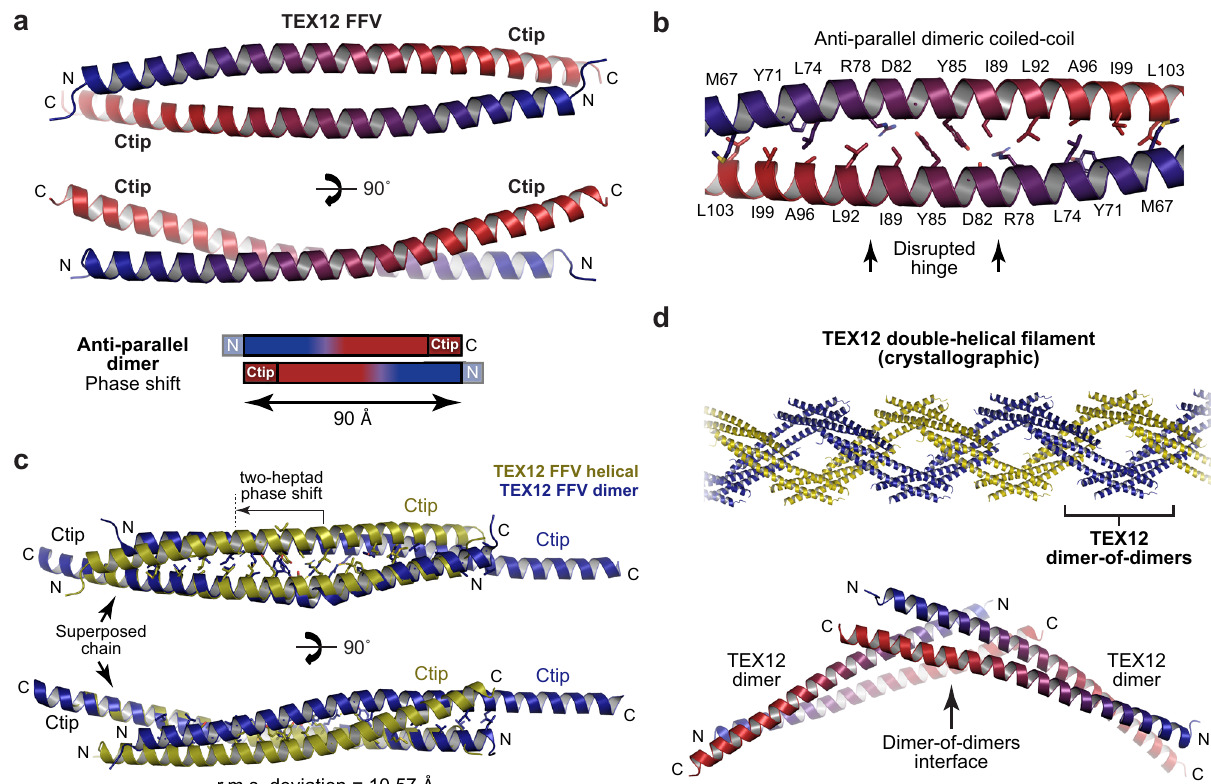
Fig. 5 Crystal structure of TEX12 FFV in a dimeric helical conformation. a Constituent dimer of the crystal structure of a TEX12 FFV helix. The two TEX12 chains (coloured blue to red in an N- to C-terminal direction) are arranged in an anti-parallel con fi guration that includes their Ctip sequences and excludes N-terminal amino-acids 49 – 59, providing a length of 90 Å. b The dimeric core is a single continuous anti-parallel coiled-coil, which contains a central aromatic interface between Y85 residues, and lacks the R78-D82 salt bridge hinge. c Comparison of the TEX12 FFV dimer structure in dimeric (blue) and helical (yellow) conformations in which structures were superposed based on a single chain, as indicated (r.m.s. deviation = 10.57). Their dimeric cores are distinct and de fi ned by a two-heptad phase shift of the helical structures in comparison with the dimeric structure. d In the TEX12 FFV crystal lattice, individual molecules interact through a recursive dimer-of-dimer interface to form right-handed helices that are intertwined in a double-helical